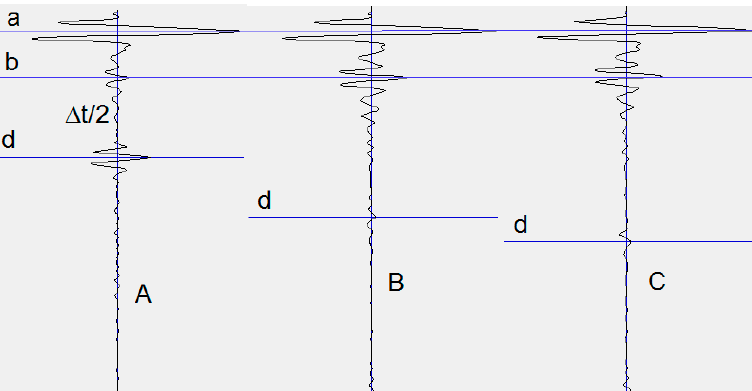
Figure 4. Traces of the radargrams of sand in experiment 1: ( A ) sand in naturally dry state; ( B ) sand after moistening with 15.1 L of water; ( C ) sand 50 h after moistening. a —a direct signal, b —upper surface of the sand, d —waterproof partition.